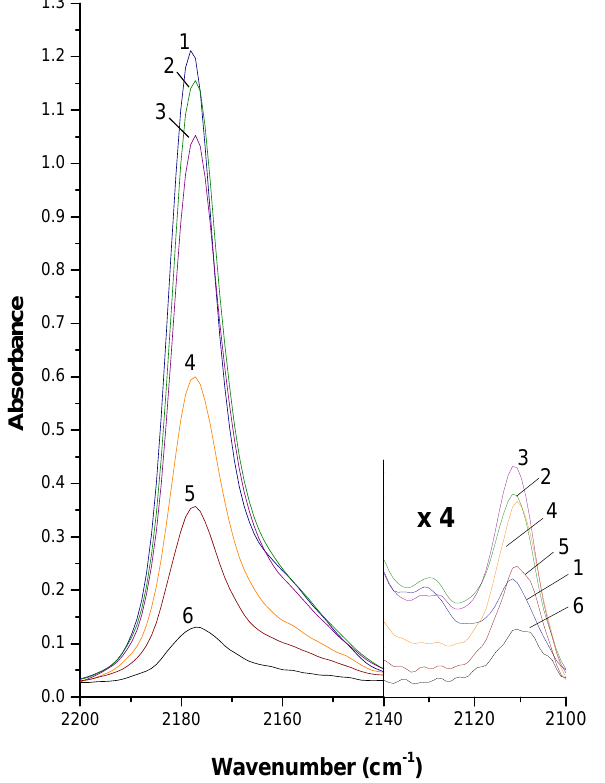
Figure 1. Selected spectra of CO ( ca . 1.5 Torr) adsorbed on Na-ZSM-5 at variable temperature: ( 1 ) 123 K; ( 2 ) 143 K; ( 3 ) 163 K; ( 4 ) 243 K; ( 5 ) 263 K; ( 6 ) 293